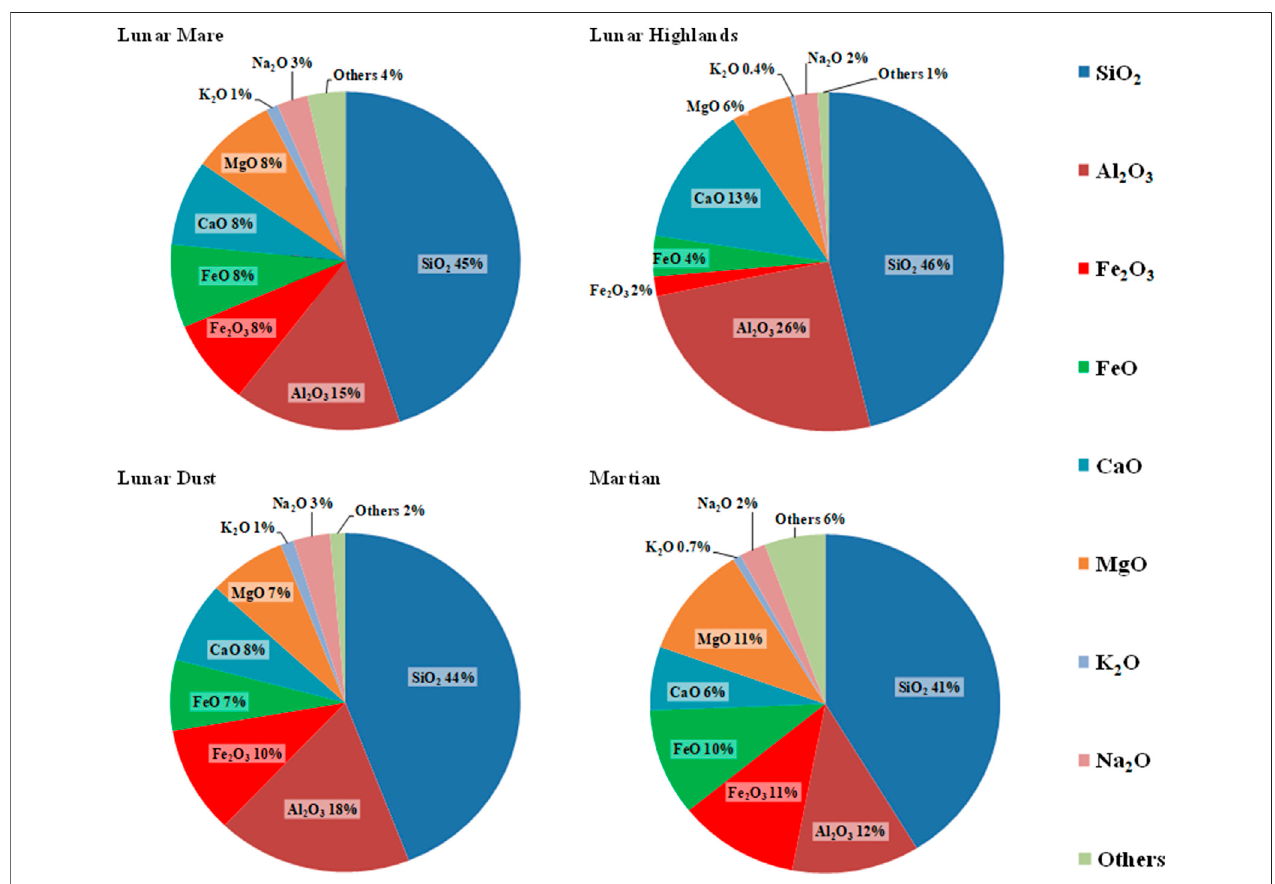
FIGURE 2 | Bulk chemistry of 30 lunar and martian simulants listed in Table 1 (the source of the information used to build the graph and the analytical techniques used to produce chemical data are reported in Table 1 and in the text).